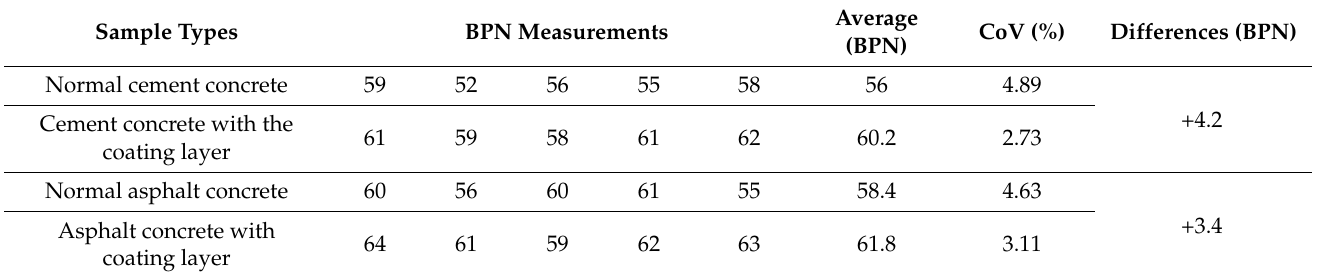
Table 1. The comparison of pendulum instrument test results